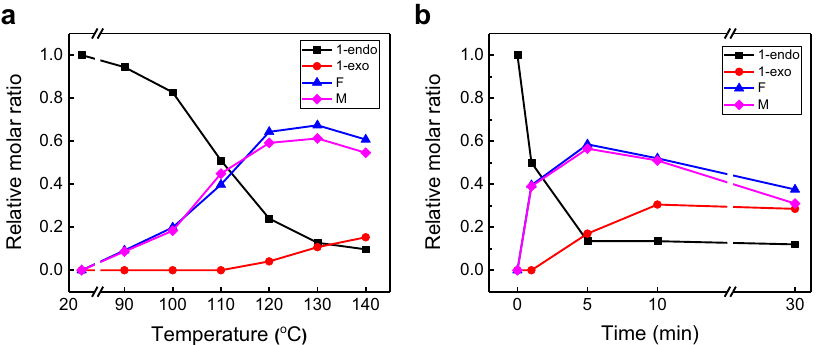
Fig. 6 Temperature and time-dependent relative molar ratios of 1-endo, 1-exo, and retro Diels – Alder (rDA) products F and M. a Relative molar ratio as a function of temperature for rDA reaction of 1-endo. b Relative molar ratios as a function of heating time at 110